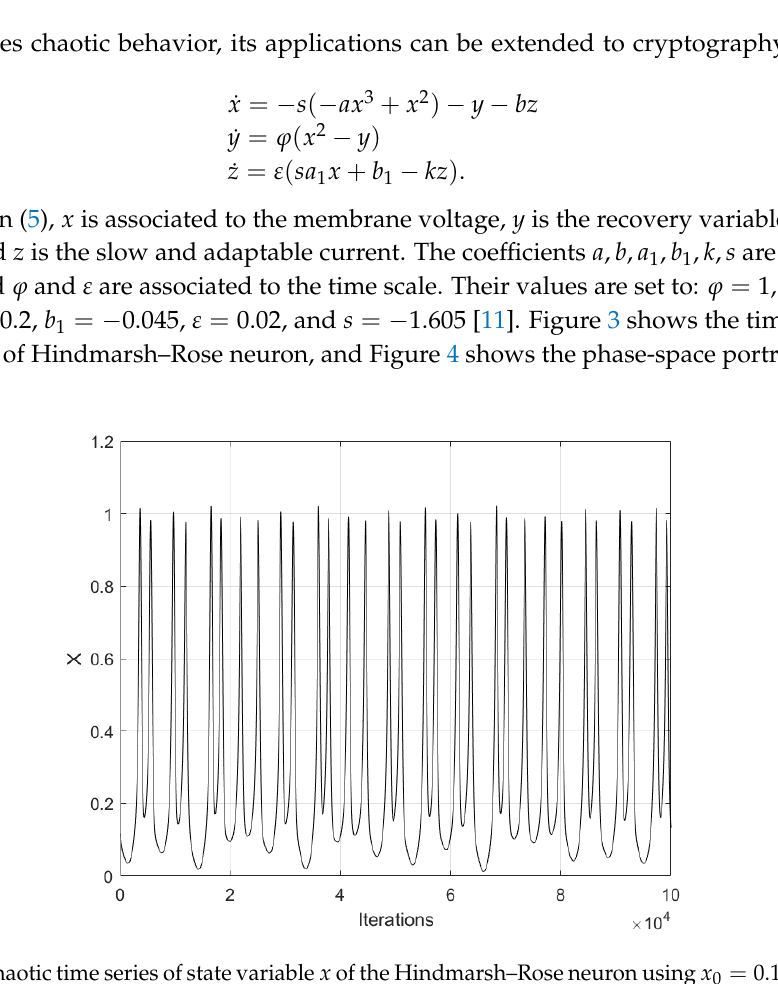
Figure 3. Chaotic time series of state variable x of the Hindmarsh–Rose neuron using x 0 = 0.1169282607,